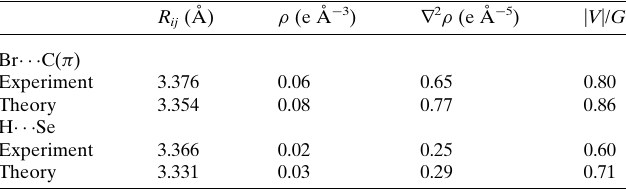
Table 2 Topological parameters at the Br (cid:2)(cid:2)(cid:2) C( (cid:3) ) and H (cid:2)(cid:2)(cid:2) Se b.c.p.s in (cid:4) -Se. R ij (A˚ ) (cid:11) (e A˚ (cid:4) 3 )